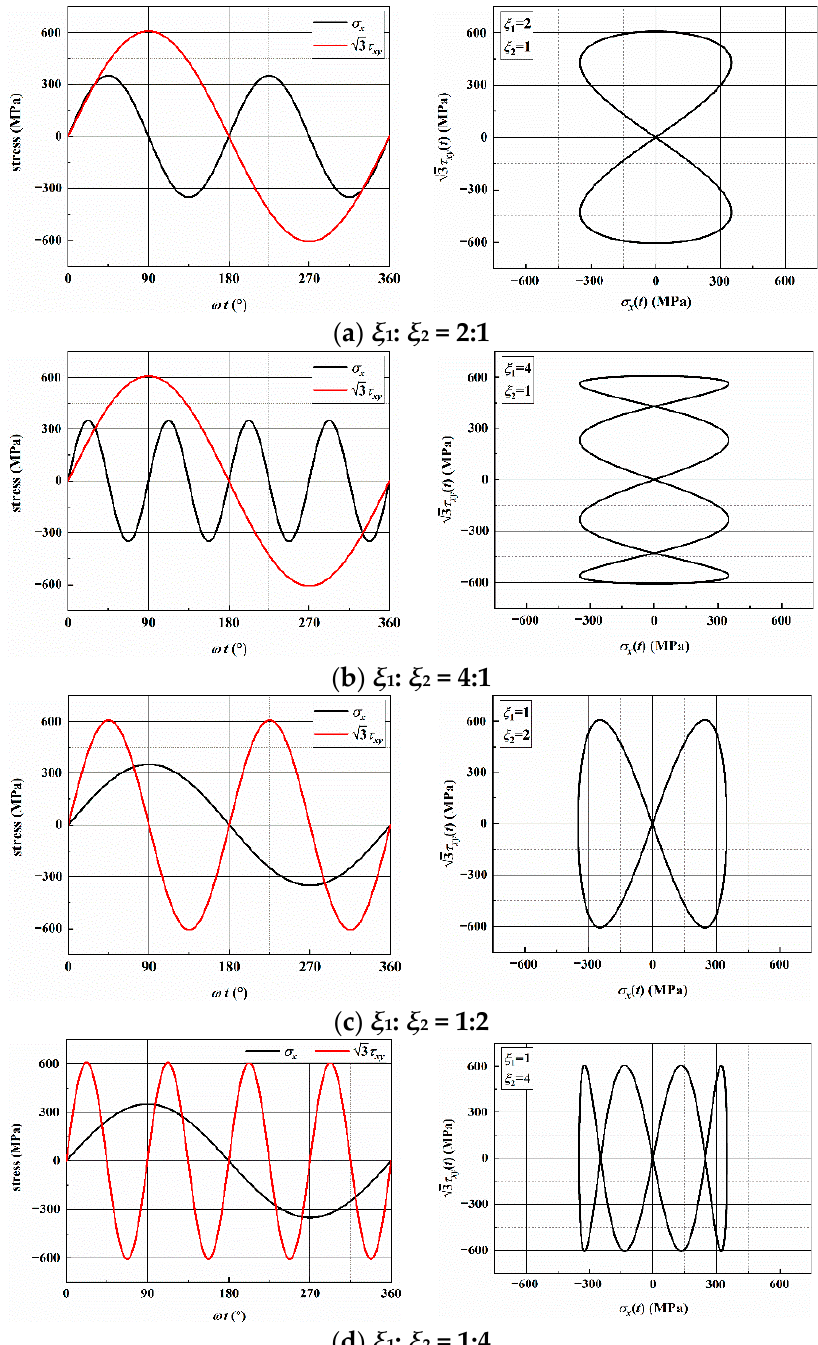
Figure 2. Multiaxial asynchronous loading paths with different frequency ratios.